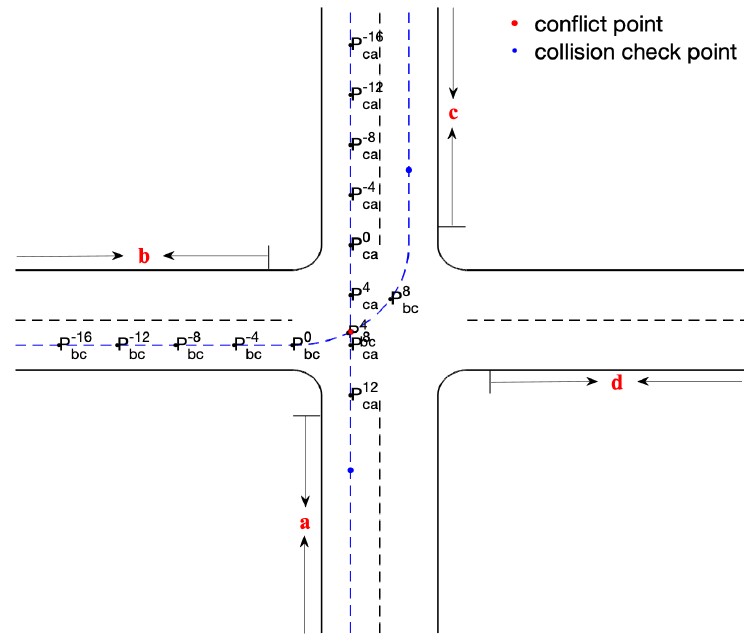
Figure 3. An illustration of discretized